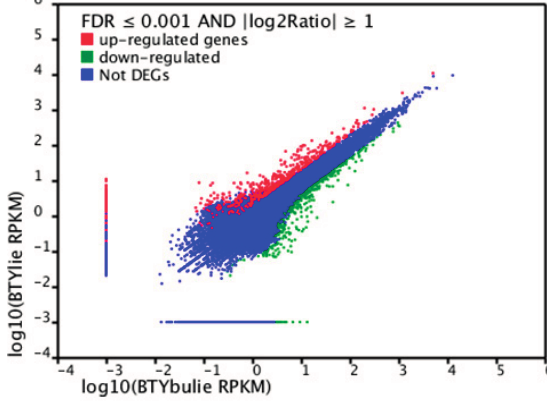
Figure 5. Comparison of transcript abundance levels between samples 1 and 2. Differentially expressed genes are shown in red and green; blue indicates genes that were not differentially expressed between the two samples.